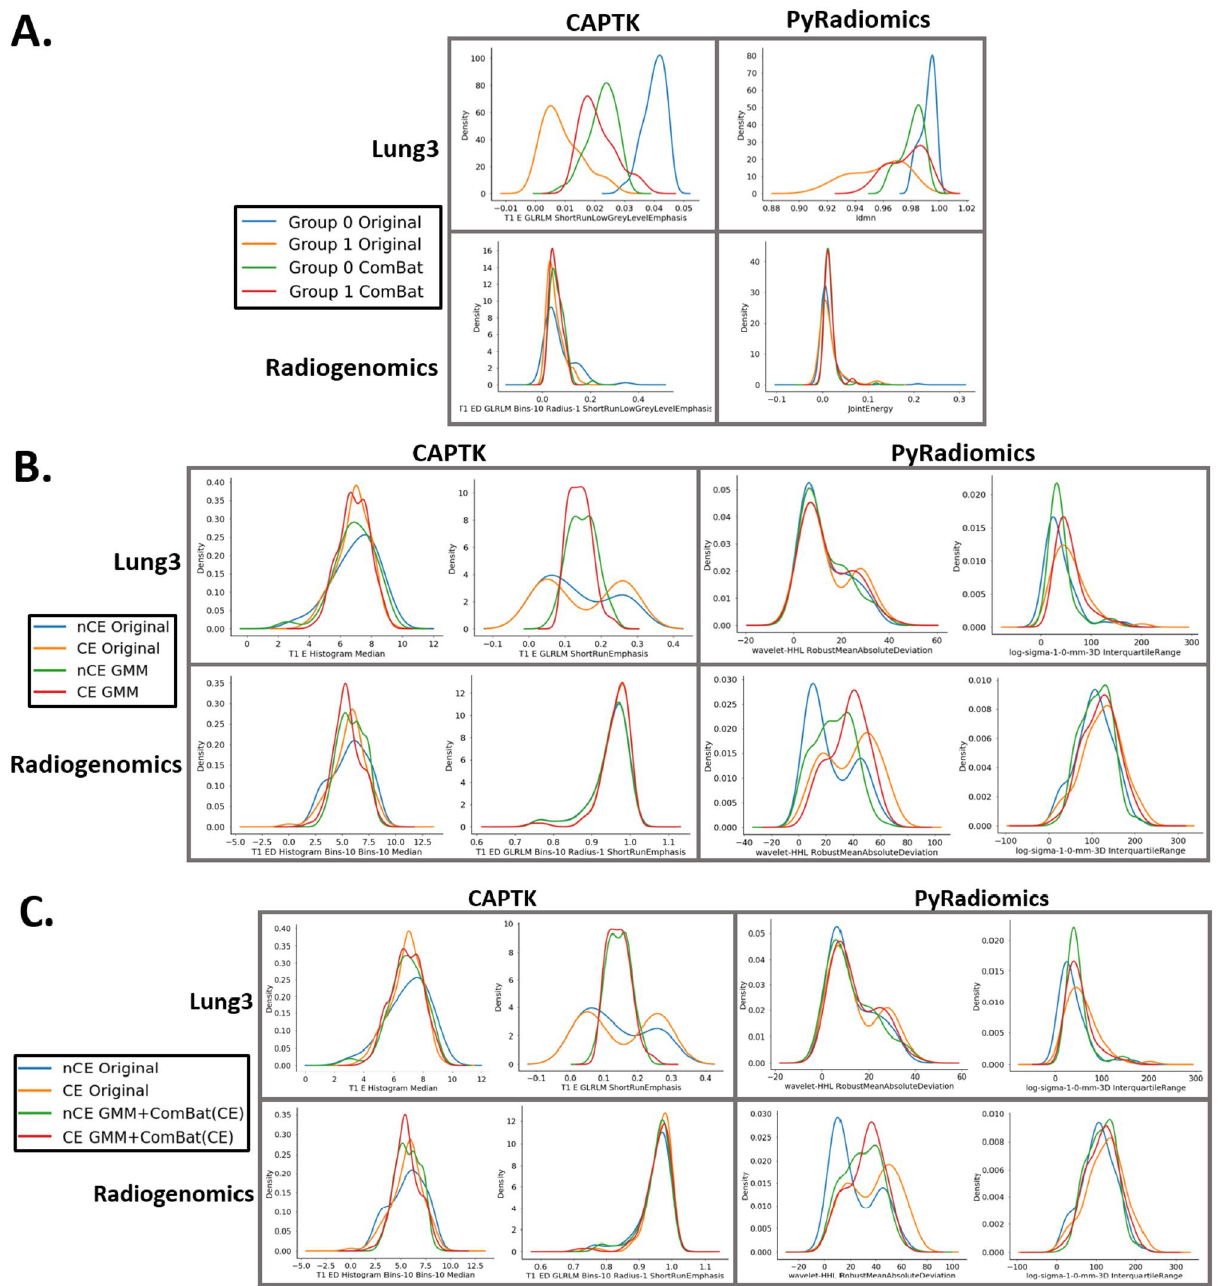
Figure 2. ( A ) Kernel density plots for the feature used to generate the GMM grouping before and after harmonization by the GMM groupings. B) Representative kernel density plots for the original features and after applying standard ComBat and harmonizing by the GMM grouping alone (GMM). C) Representative kernel density plots for the original features and after harmonizing by both the GMM grouping and known imaging parameter batch effects (GMM + ComBat (CE)). Kernel density plots represent ComBat results separated by the batch variable contrast enhancement, where nCE indicates no enhancement and CE indicates enhancement. For ( B ) and ( C ), representative features whose distributions best visually demonstrate the effects of GMM ComBat were selected by screening all the feature distributions before and after harmonization. Harmonization should result in more similar feature